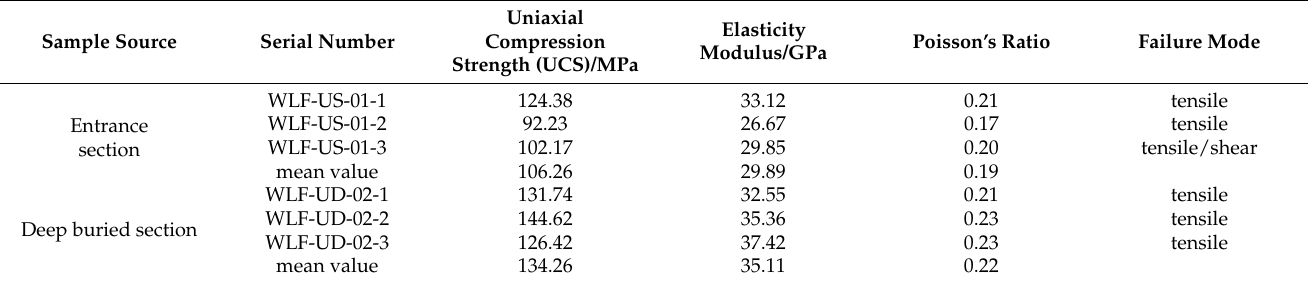
Table 3. Results of uniaxial compression test.